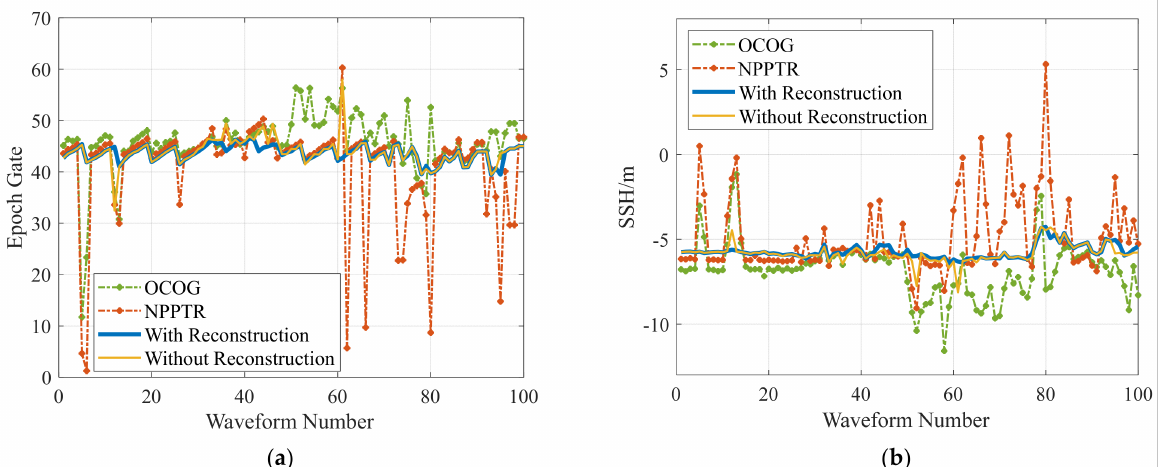
Figure 12. ( a ) Epoch-retracking results for experimental area 1 in September. ( b ) Mean SSH data for experimental area 1. The green and red dotted lines represent the OCOG retracking results and the NPPTR results, and the blue and yellow solid lines represent the retracking results of the reconstructed and original